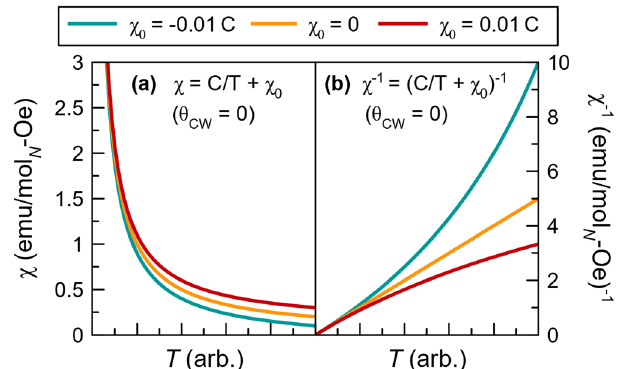
Fig. 3 Effect of a temperature independent contribution to susceptibility on Curie – Weiss behavior. The effect of a small temperature independent contribution to the magnetic susceptibility, χ 0 , on Curie – Weiss behavior. The yellow curve shows the behavior or a material with χ 0 = 0 while blue and red include, respectively, a small negative and a small positive χ 0 . a In the direct susceptibility, Curie – Weiss behavior is still evident for all three curves, b while in the inverse susceptibility a signi fi cant positive (red) or negative (blue) curvature is observed that must be accounted for (see Eqn. (9)) in order to fi t the